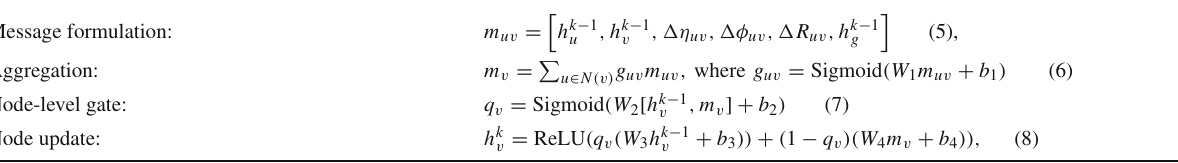
Fig. 2 Node representation h v update for the k th iteration Table 1 Message passing and representation updates in the graph neural